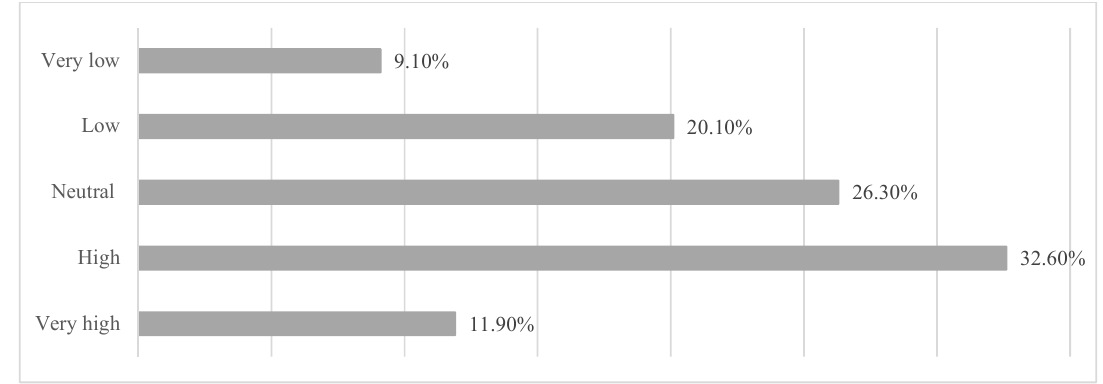
Fig 3 . Respondents’ willingness to take the risks